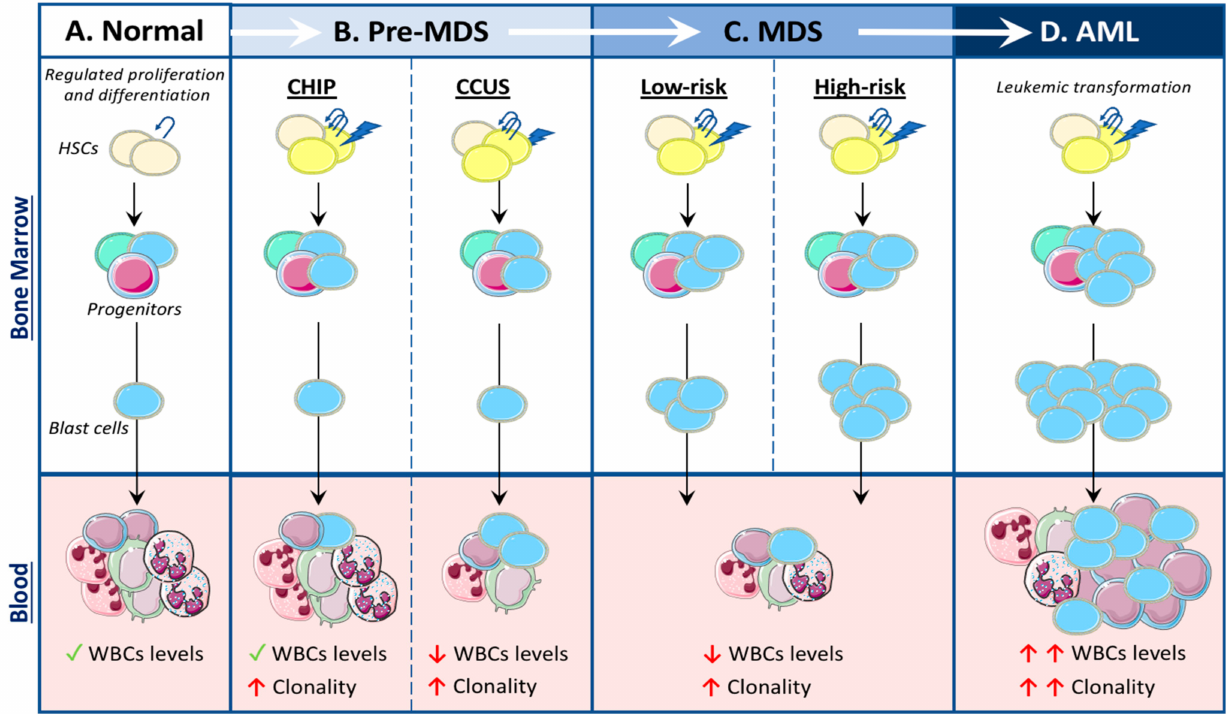
Figure 1. Transformations from normal hematopoiesis to acute myeloid leukemia (AML) development. ( A ) Normal: Normal hematopoiesis is highly regulated, whereby hematopoietic stem cells (HSCs) can self-renew and differentiate into progenitor cells. Progenitor cells differentiate into immature blood cells (blast cells) and then into mature white blood cells (WBCs). ( B ) Pre-MDS (myelodysplasia syndrome): Clonal hematopoiesis of indeterminate potential (CHIP) occurs when a HSC acquires a somatic mutation resulting in a proliferative advantage; giving rise to a mutated clone. While the levels of WBCs do not change, there are mutated clonal WBCs detected in the blood. Clonal cytopenia of undetermined significance (CCUS) presents with CHIP, as well as with cytopenia. ( C ) MDS: The development of significant bone marrow (BM) blast cells, BM dysplasia and cytopenia is usually associated with at least 1 genetic abnormality (either a gene mutation or chromosomal defect). MDS is considered low risk (transformation potential) when blast cell numbers are relatively low, and high risk when BM dysplasia is advanced. ( D ) AML: A leukemic transformation occurs that results in excessive BM expansion, BM dysplasia and pathological WBC